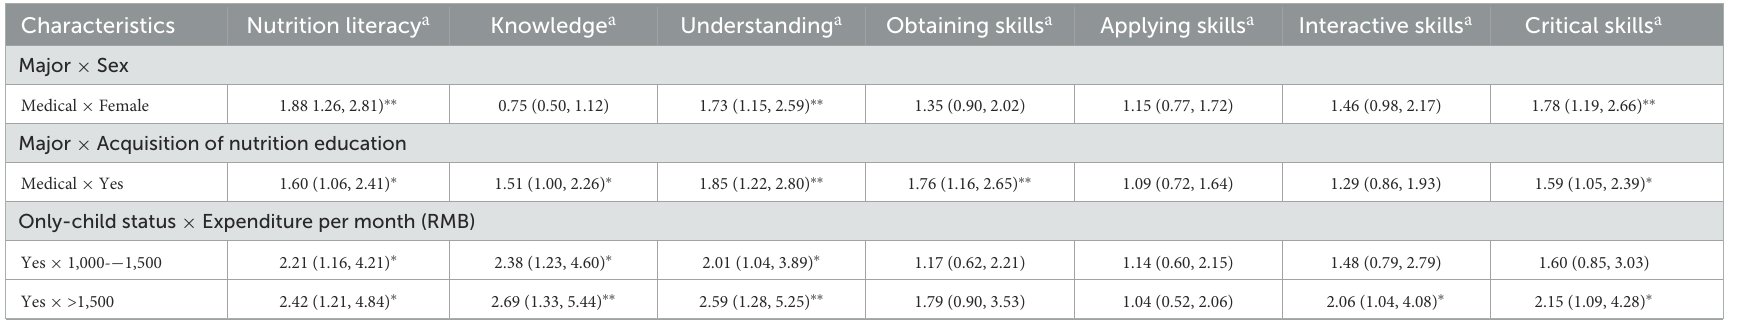
TABLE 3 The impact of multiple factor interactions on total nutrition literacy and its six